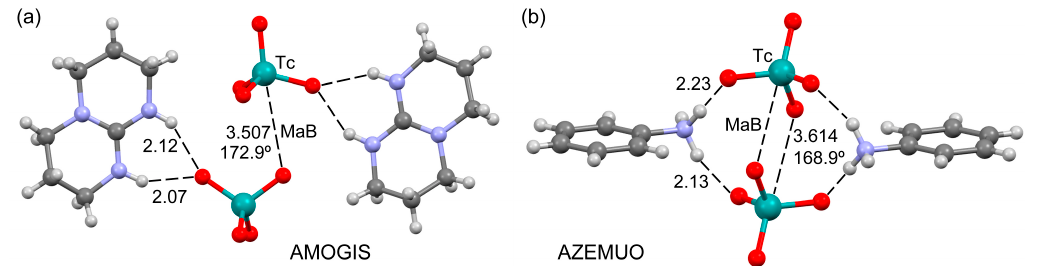
Figure 1. Ball and stick representation of the X-ray structures AMOGIS ( a ) and AZEMUO ( b ). Distances in Å. Color code: Carbon grey, Oxygen red, Nitrogen blue, Technetium teal, Hydrogen light grey.